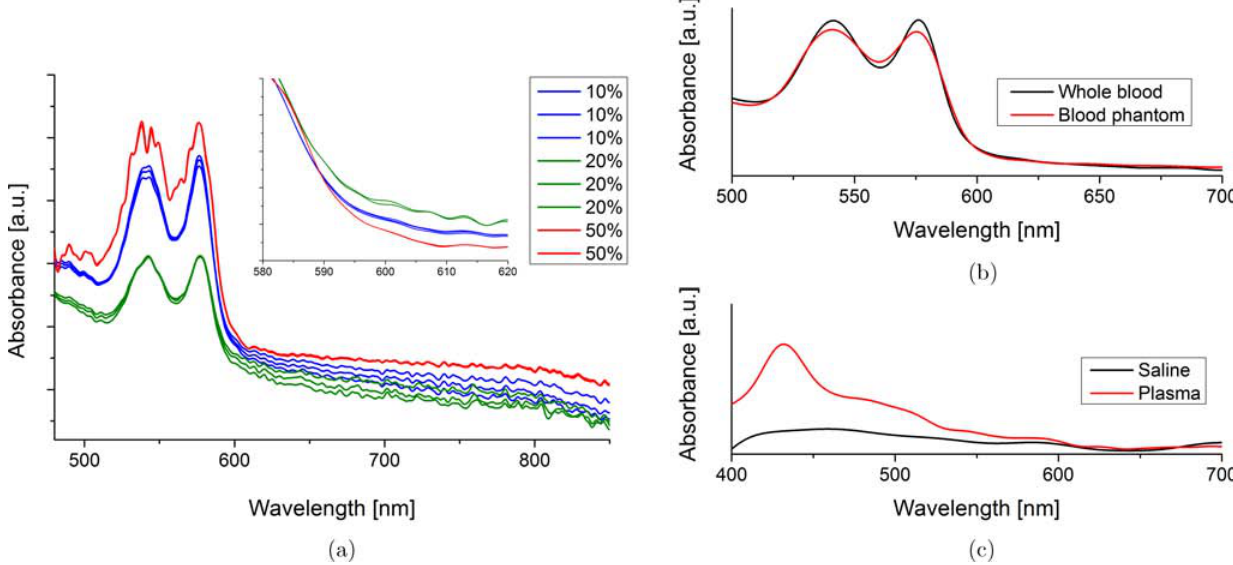
Fig. 7. Comparison of absorption spectra of blood constituents: (a) Comparison of washed erythrocytes (blood phantom) with various HCT levels; the inset presents the change in the slope of absorbance in 580 – 620 nm range on normalized spectra. (b) Comparison of absorbance of whole blood and phantom at HCT of about 50% in both cases. (c) Comparison of absorbance of saline and plasma.